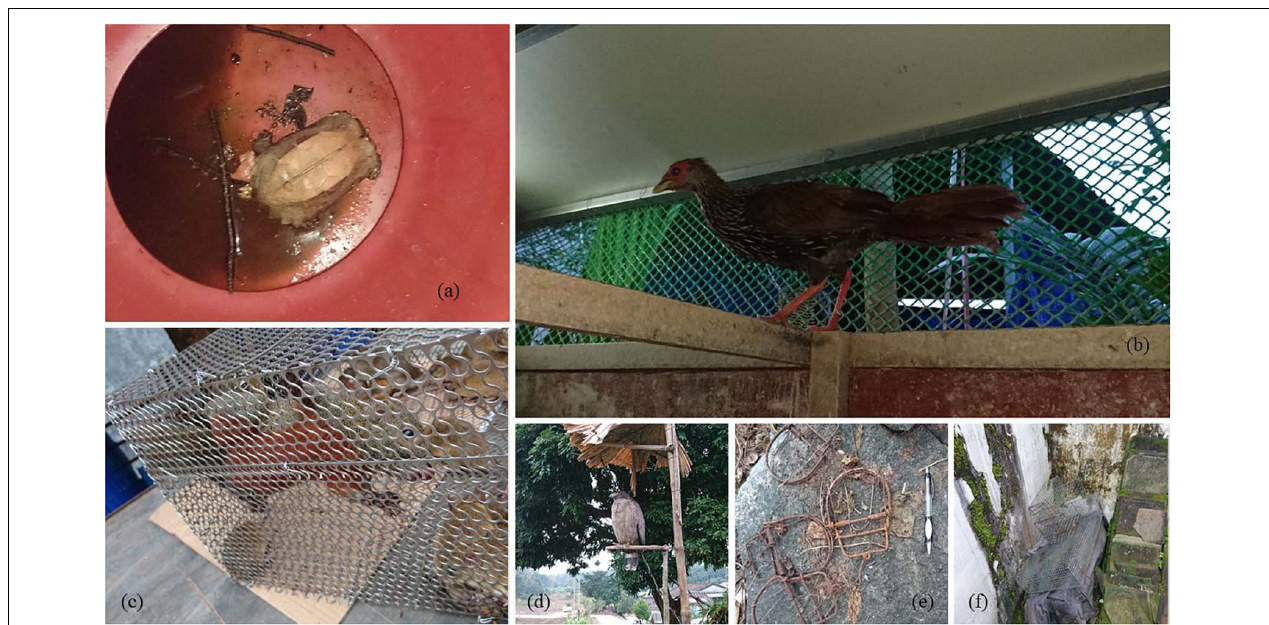
FIGURE 2 | Captive wild animals and hunting gears observed in villages during fieldwork. (a) Black-breasted leaf forest turtle ( Geoemyda spengleri ); (b) female silver pheasant ( Lophura nycthemera ); (c) Pallas’s squirrel ( Callosciurus erythraeus ); (d) crested serpent eagle ( Spilornis cheela ); (e) snap traps; (f) cage traps. Photo credit: Yifu Wang.